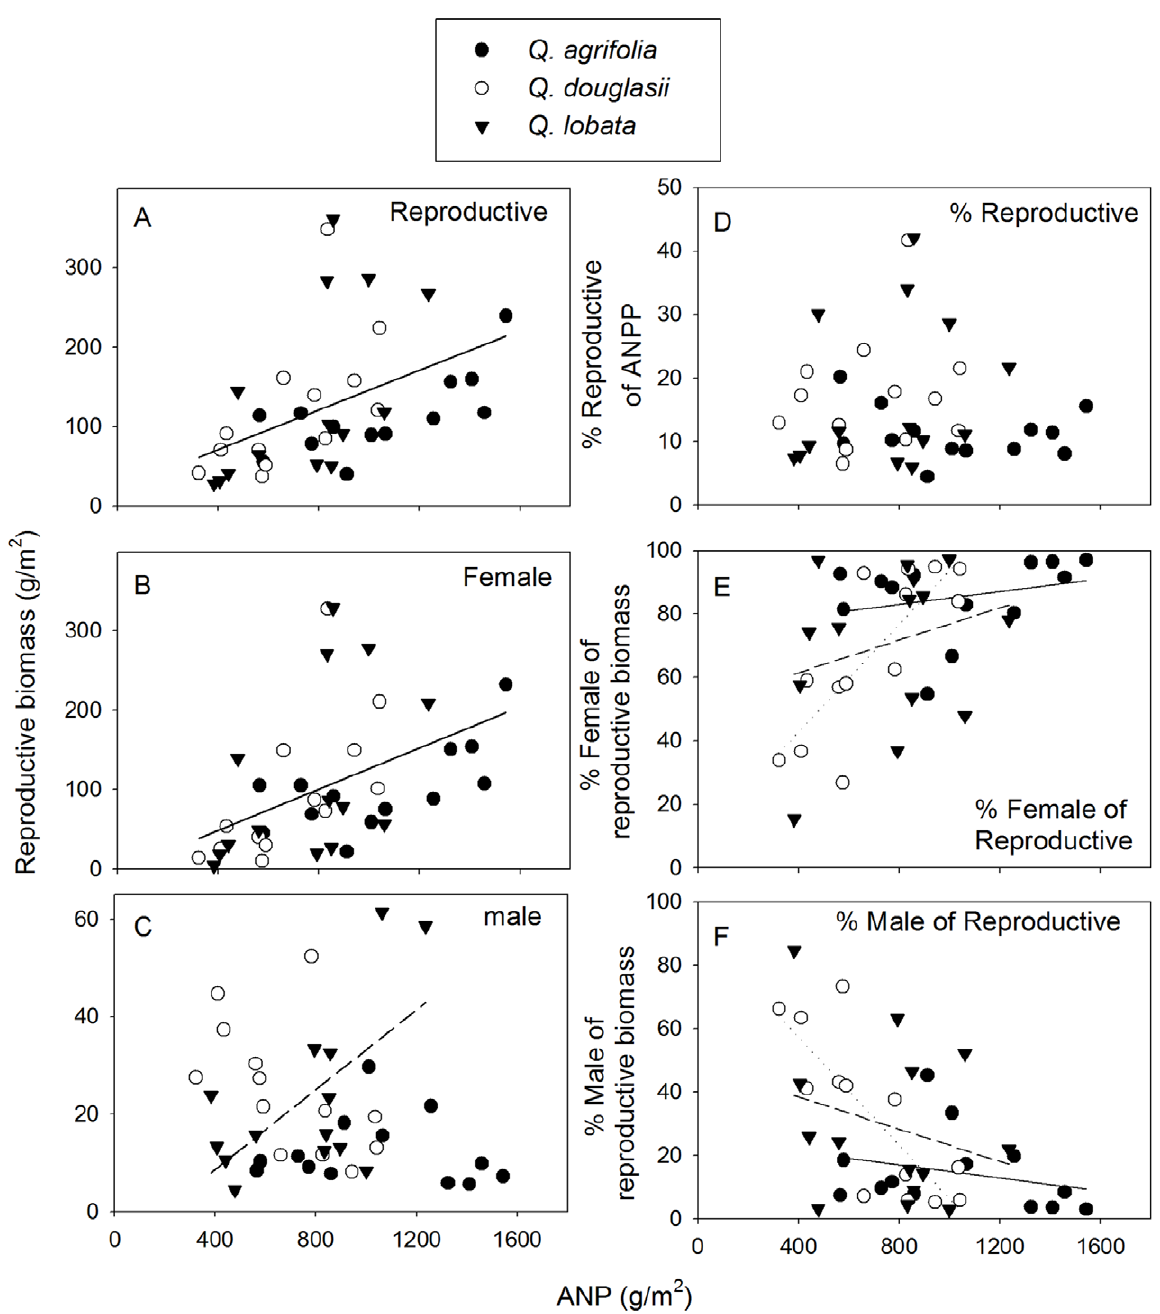
Figure 3. Annual aboveground net productivity (ANP) in three California oak species in relation to reproduction. Shown are ANP in relation to (A) total reproductive biomass, (B) female reproductive biomass, (C) male reproductive biomass, (D) percent reproductive biomass of ANP, (E) percent female reproductive biomass of total reproduction, and (F) percent male reproductive biomass of total reproduction. Plotted are the five year means of the 40 individual trees. ANP was calculated from aboveground litterfall and an estimate of trunk increment based on dendrometers. Lines are drawn for species averages in A and B, Q. lobata only in C, and in E and F solid line for Q. agrifolia , long dashed line Q. lobata and short dashed line Q. douglasii based on GLMs (Table 2). For Q. lobata only there was a significant positive relationship between ANP and male allocation ( R 2 =0.38, P , 0.02). doi:10.1371/journal.pone.0043492.g003 (Table S1). Thus, trees in productive sites initiated more acorns Discussion and the pattern of increased female reproductive effort in more Evidence presented here indicates that ANP differences among fertile sites was not the result of selective abortion of acorns in individuals of the three California oak species studied reflect unproductive sites. differences in site quality, and that differences in reproductive